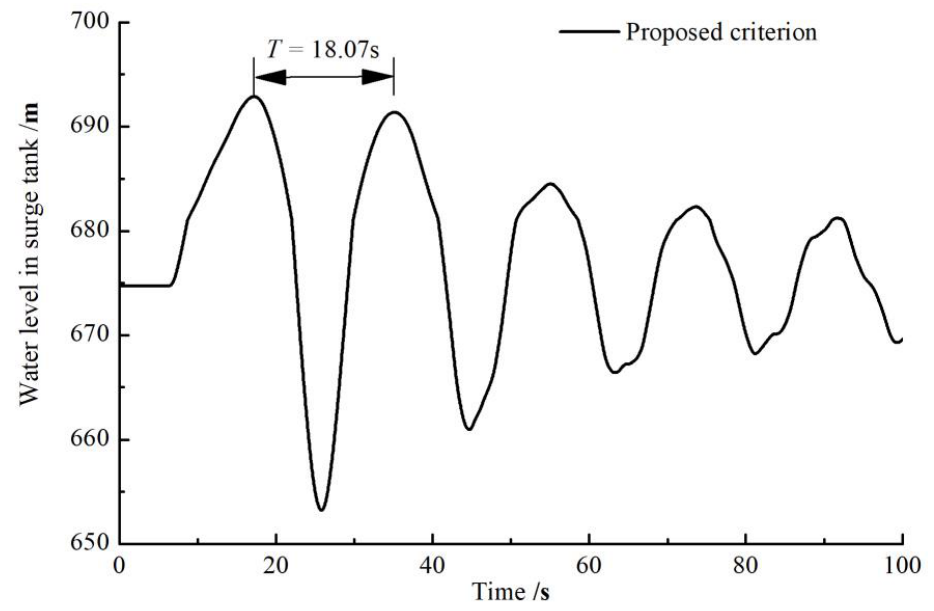
Figure 10. WLO process of the headrace ST in case 2 under 100% load rejection.